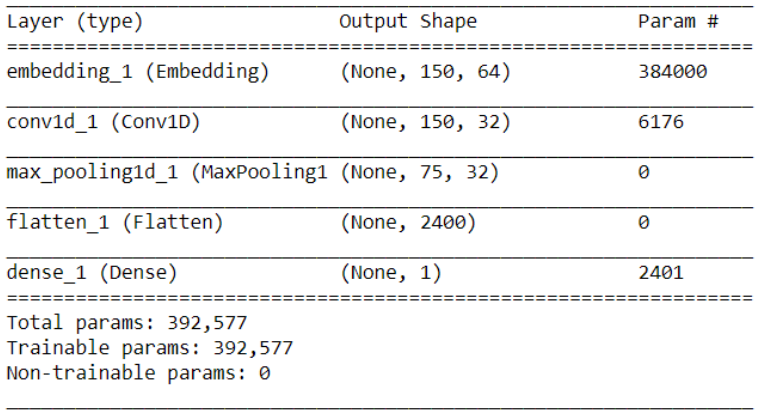
Figure 5. Parameters of CNN architecture.